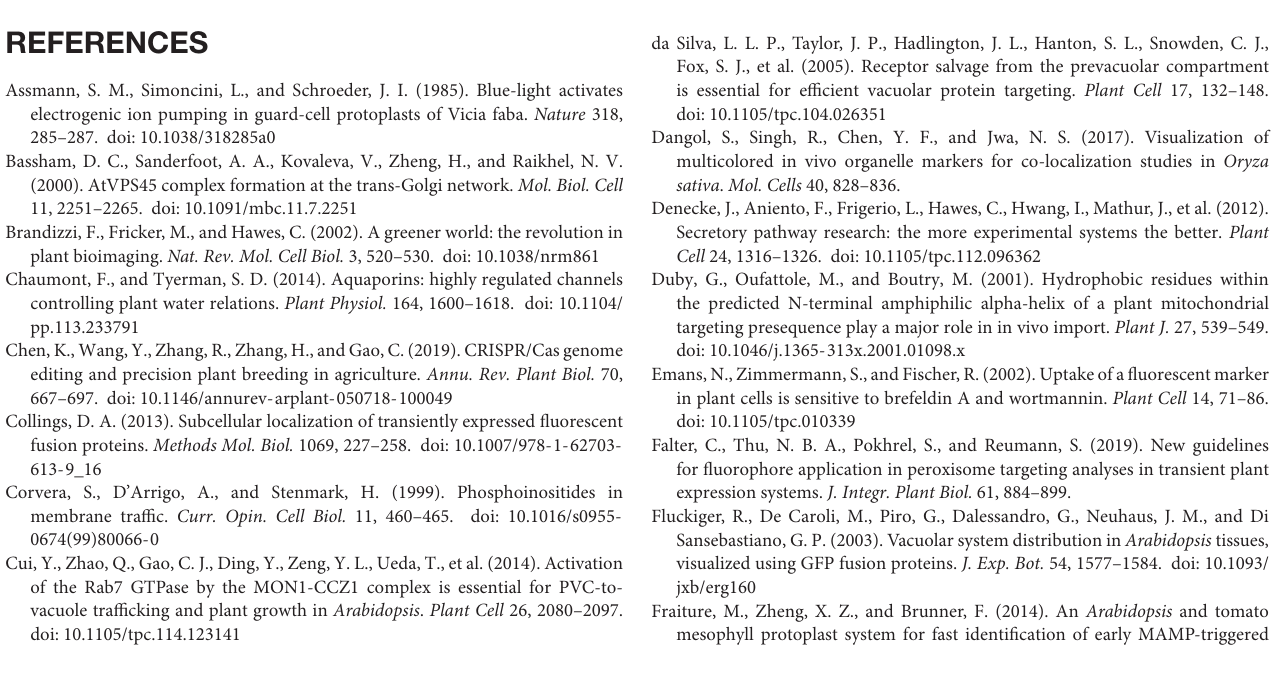
Supplementary Figure 3 | Related to Figure 4 . Colocalization analysis of different fluorescent tag fused markers on PM, ER, and vacuole in moso bamboo protoplasts. (A) Colocalization of GFP-PeVAMP721 with mRFP-PeVAMP721. (B) Colocalization of PeCNX-GFP with PeCNX-mRFP. (C) Colocalization of GFP-PeVIT1 with mRFP-PeVIT1. (D) Colocalization of GFP-PeVAMP711 with mRFP-PeVAMP711. (E) Colocalization of PeAleurain–GFP with aleurain-mRFP after ConcA (200 nM) treatment. DIC, differential interference contrast. Scale bar = 5 µ m. Supplementary Figure 4 | Related to Figure 5 . Colocalization analysis of different fluorescent tag fused markers on endosomal compartments in moso bamboo protoplasts. (A) Colocalization of GFP-PeMEMB12 or with mRFP-PeMEMB12. (B) Colocalization of PeERD2-GFP with PeERD2-mRFP. (C) Colocalization of GFP-PeVTI12 with mRFP-PeVTI12. (D) Colocalization of GFP-PeSYP42 with mRFP-PeSYP42. (E) Colocalization of GFP-PeARA7 with mRFP-PeARA7. (F) Colocalization of GFP-PeVSR1 with mRFP-PeVSR1. DIC, differential interference contrast. Scale bar = 5 µ m. Supplementary Figure 5 | Related to Figure 6 . Response of endosomal markers to pharmaceutical treatment in moso bamboo protoplasts. (A) Subcellular localization analysis of TGN localized GFP-PeVTI12 with Arabidopsis TGN marker mRFP-SYP61 after BFA treatment. (B) Subcellular localization analysis of GFP-PeARA7 with Arabidopsis PVC/MVB marker mRFP-AtVSR2 after wortmannin (Wort) treatment. Scale bar = 5 µ m. Supplementary Table 1 | Combinations of digestion enzymes used. Supplementary Table 2 | Examples of Expression profiles of intracellular vesicle trafficking regulators in moso bamboo. Supplementary Table 3 | Detailed information of primer sequences for each